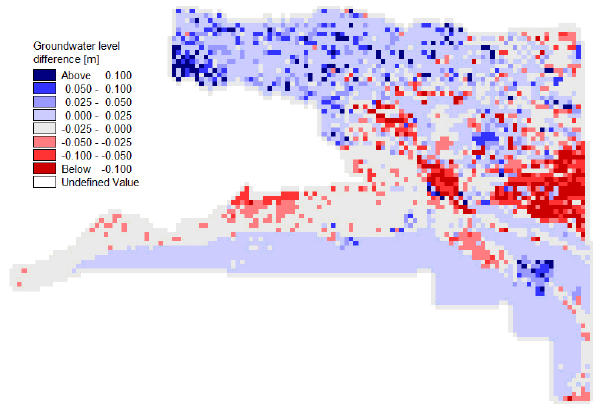
Fig. 14. Mean level of impact results (for A1B scenario) on the average groundwater level for the period 2000 ∼ 2001 in the entire study area after MIKE-SHE simulation.